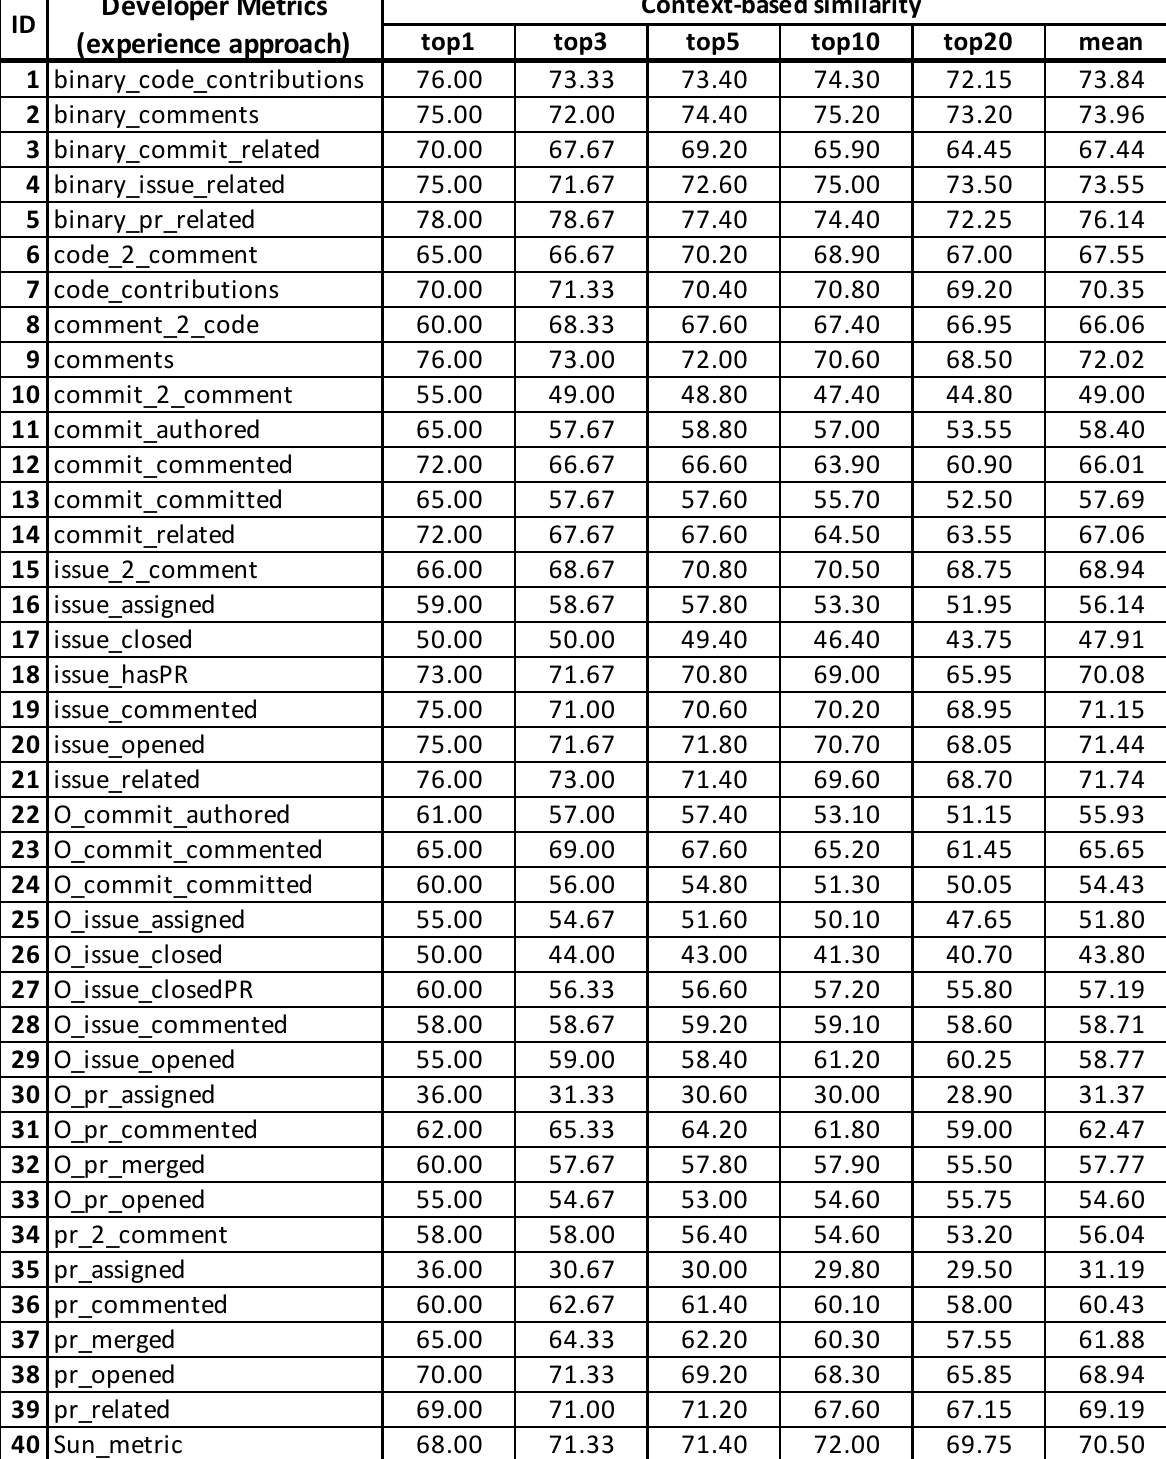
Table A4. All developer metrics all scores to evaluate with the experience approach